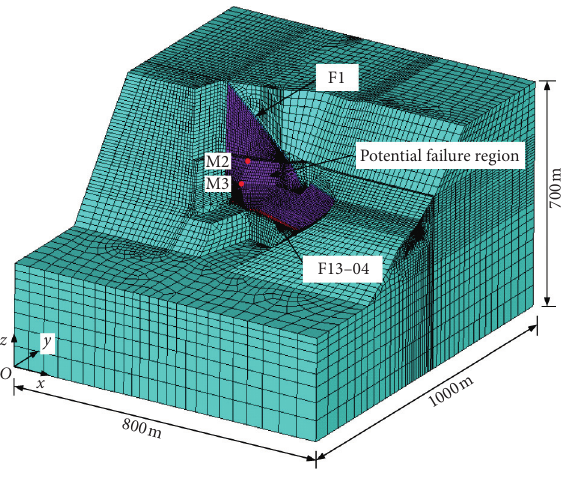
Figure 12: The 3D numerical model of the slope.